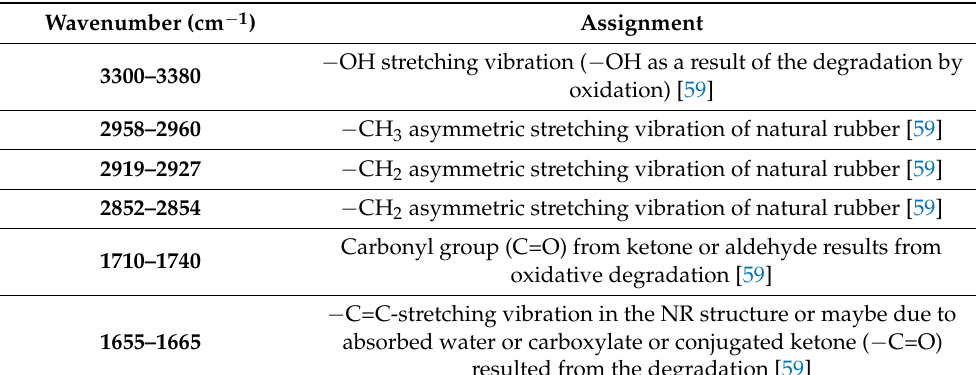
Table 5. IR bands assignment of NRL, BLF, and NRL